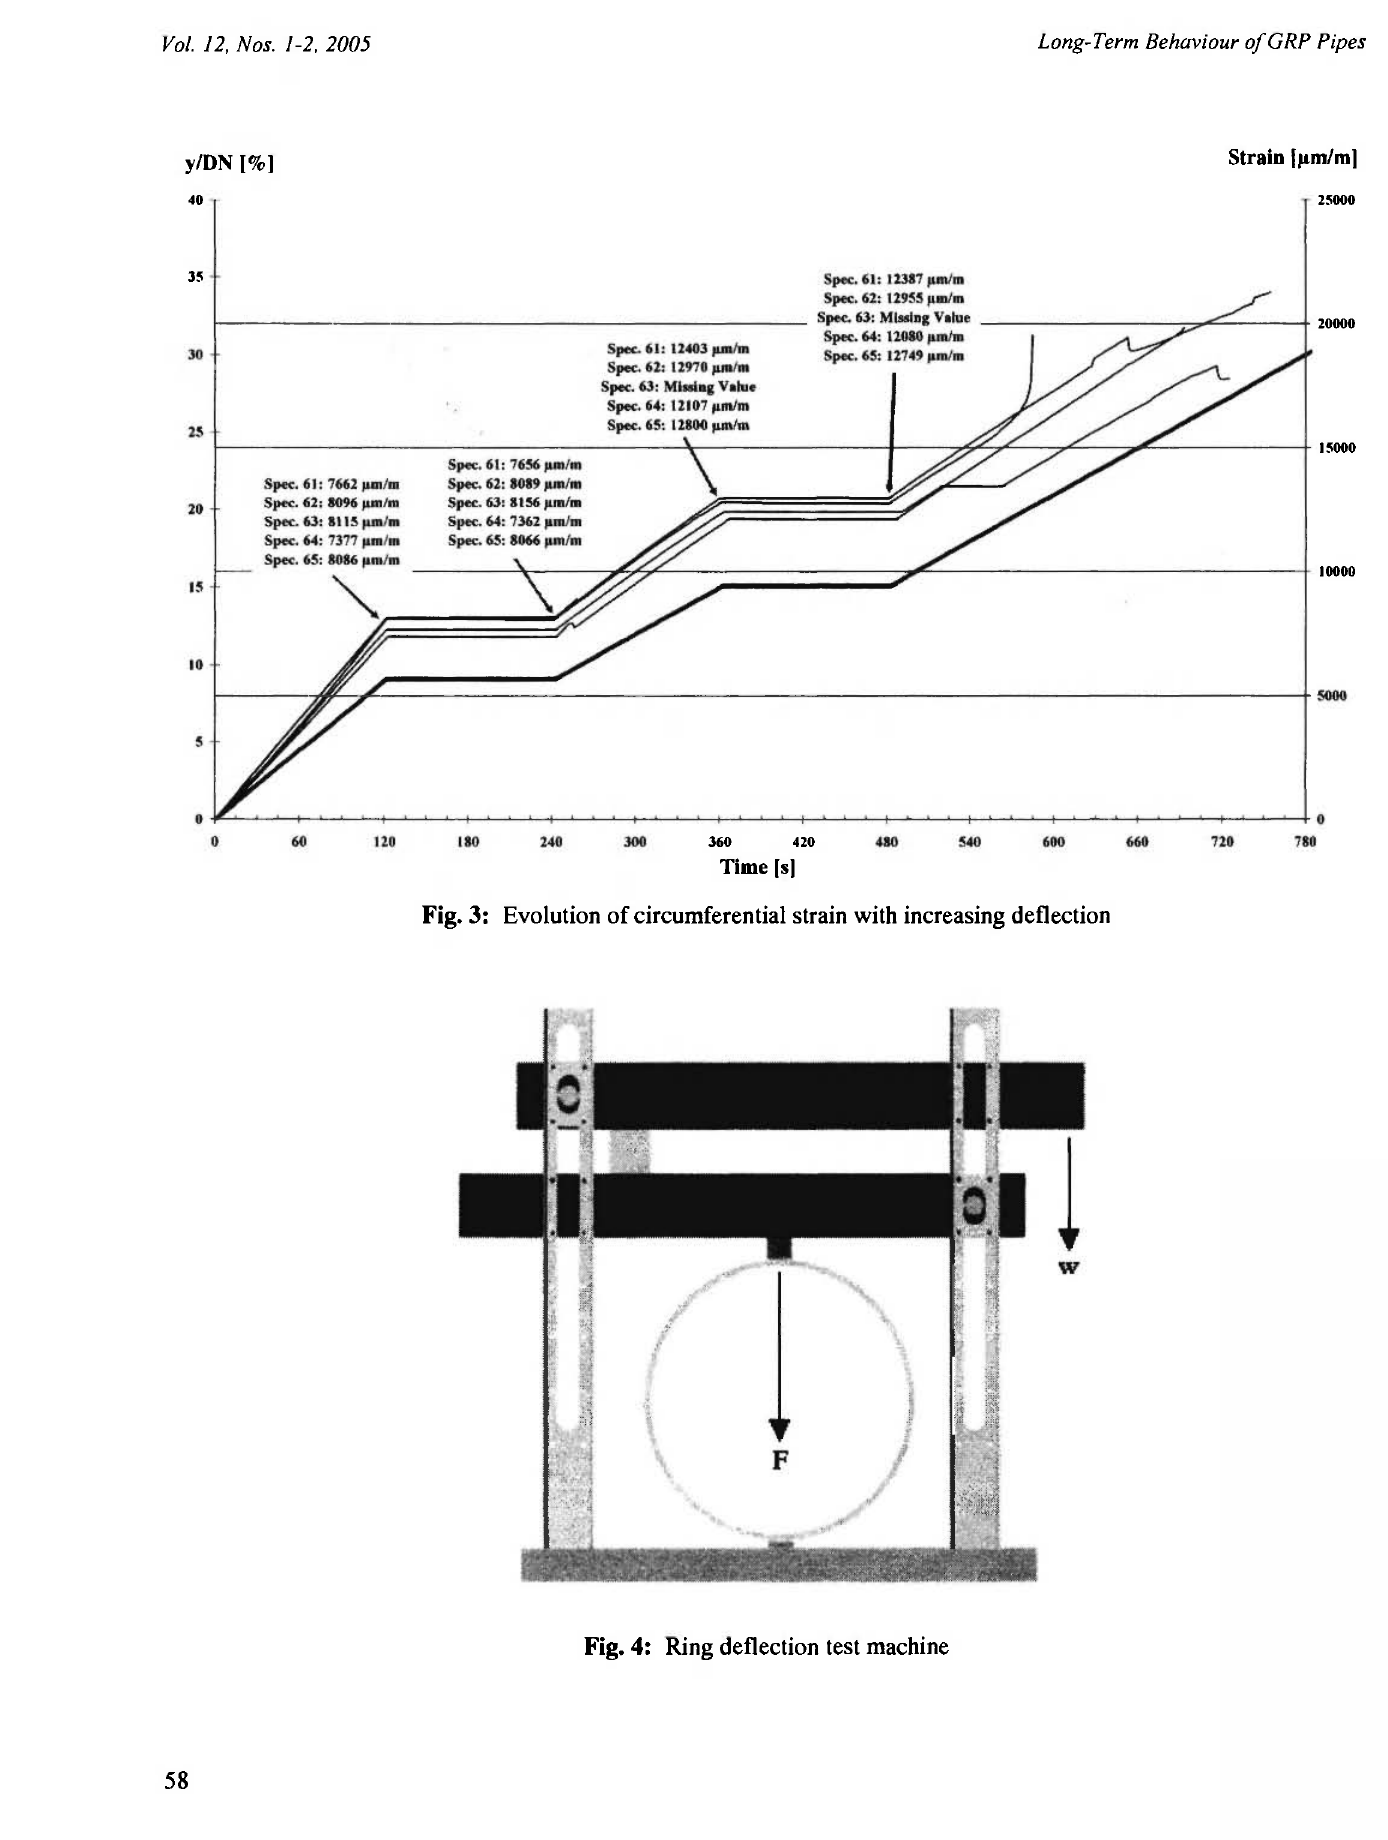
Fig. 4: Ring deflection test